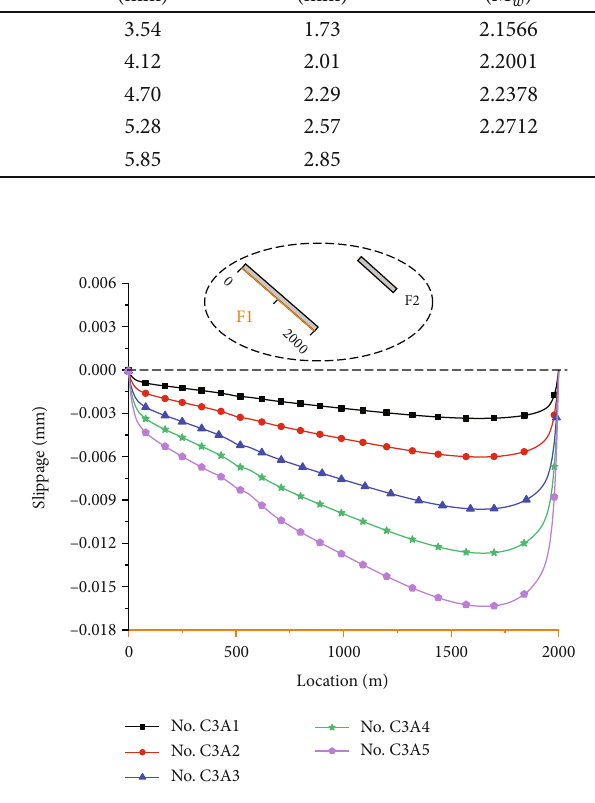
Figure 20: The induced fault slippage of F1 of di ff erent fracturing region areas (Nos.